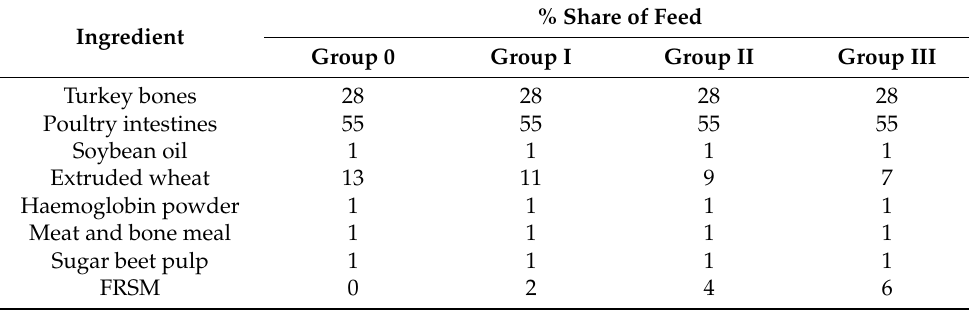
Table 2. Composition of the feed ration for mink during the experiment (% share).